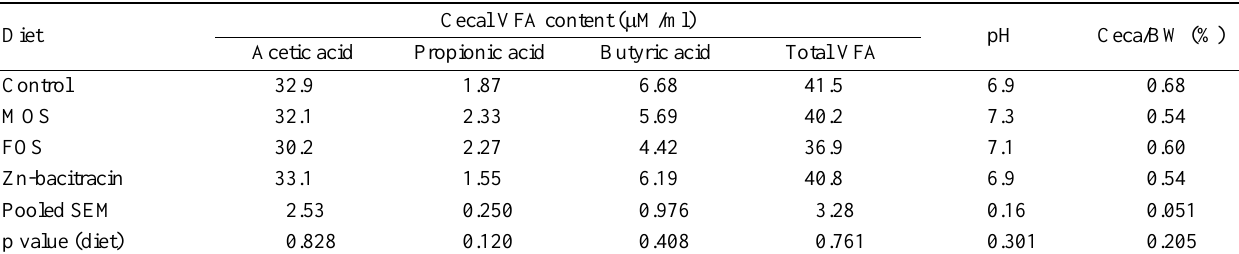
Table 4. Effects of oligosaccharides and antibiotic supplementation cecal VFA content pH and weight at d 35 (n = 8) Diet